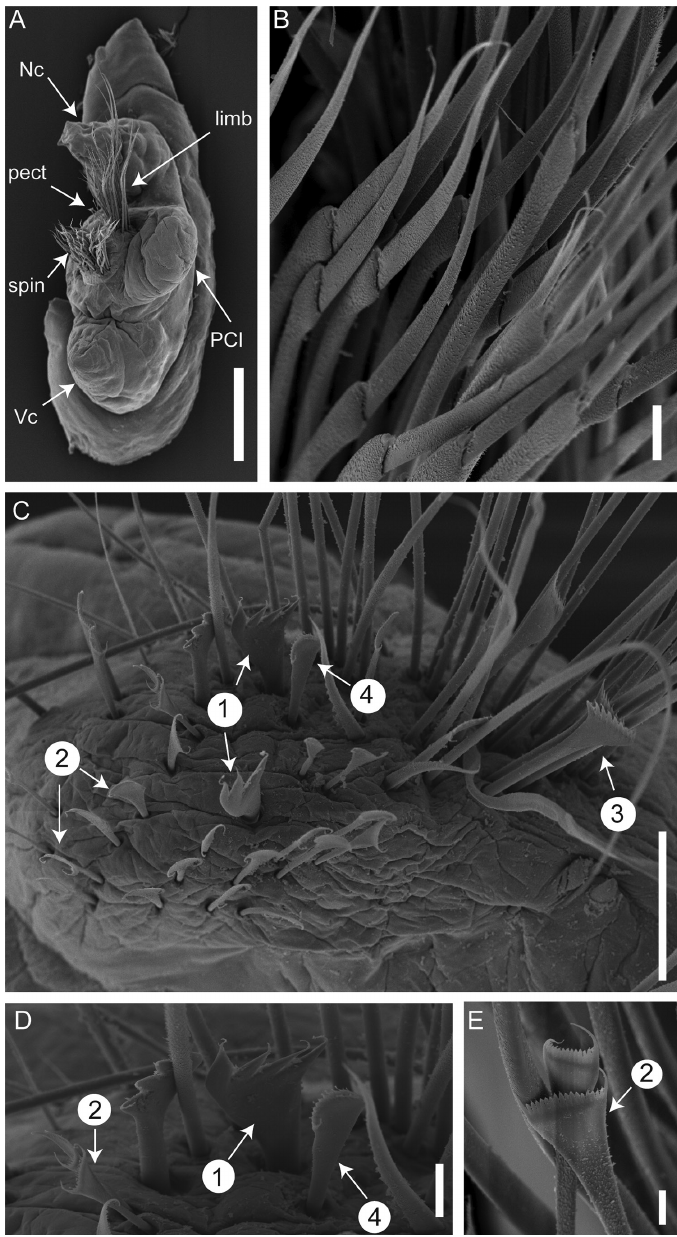
Figure 4. SEM images of Marphysa victori sp. n. (holotype AM W.49047): A entire lateral view of chaeti- ger 3 B Compound spinigers chaetae (chaetiger 83) C – D Different types of pectinate chaetae (chaetiger 243) E Isodont, symmetrical chaetae with many teeth (chaetiger 03). Numbers in white circles indicate the type of pectinate chaetae; limb, limbate chaetae; Nc, notopodial cirri; PCl, postchaetal lobe; pect, pectinate chaetae; spin, spiniger chaetae; Vc, ventral cirri. Scale bars: 500 µm ( A ), 200 µm ( B ), 100 µm ( C ), 20 µm ( D ), 10 µm ( E